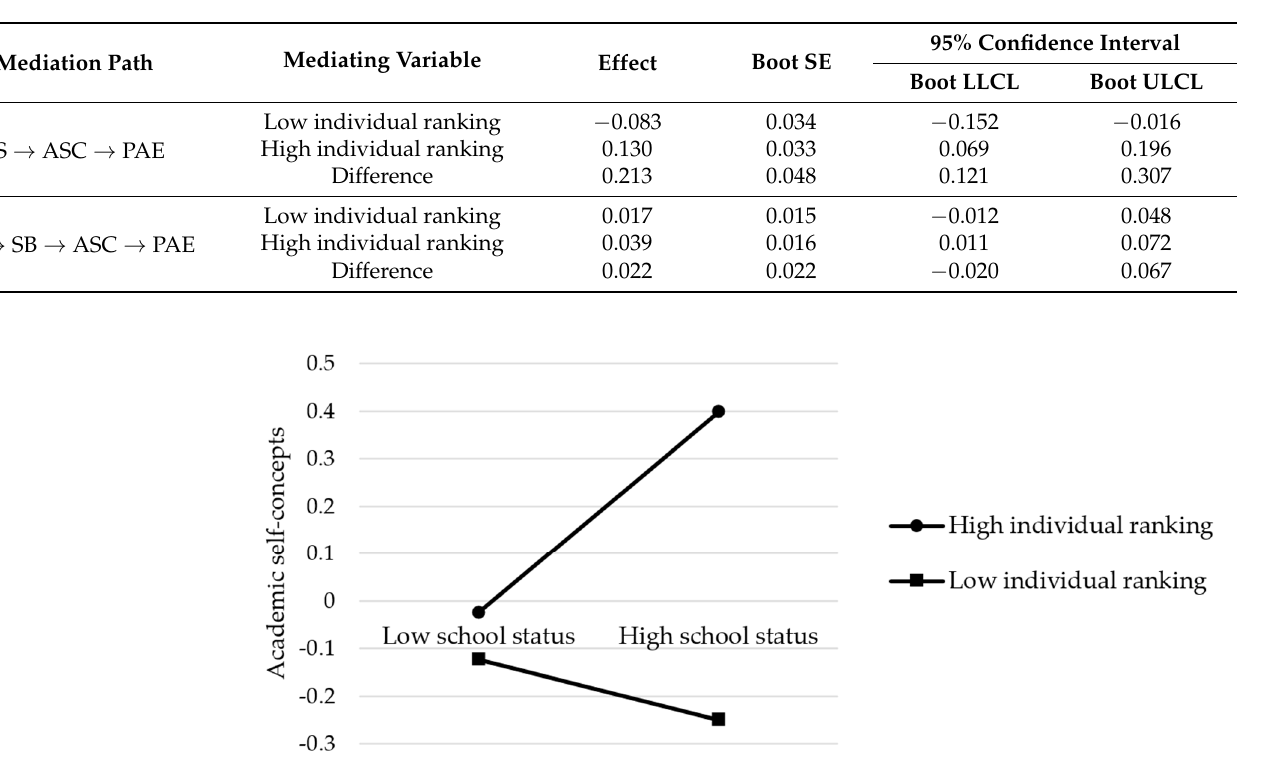
Figure 4. A diagram of the moderating effect of individual ranking on the path from school status to academic